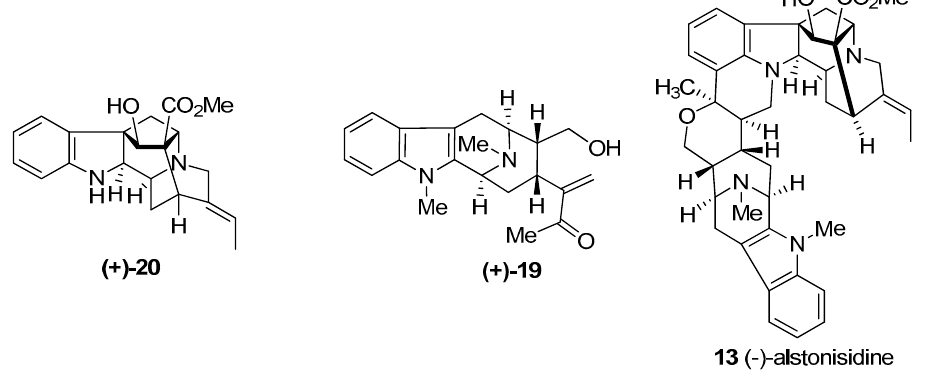
Figure 6. Structures of (+)-quebachidine ( 20 ), (+)-macroline ( 19 ), and ( − )-alstonisidine ( 13 ).